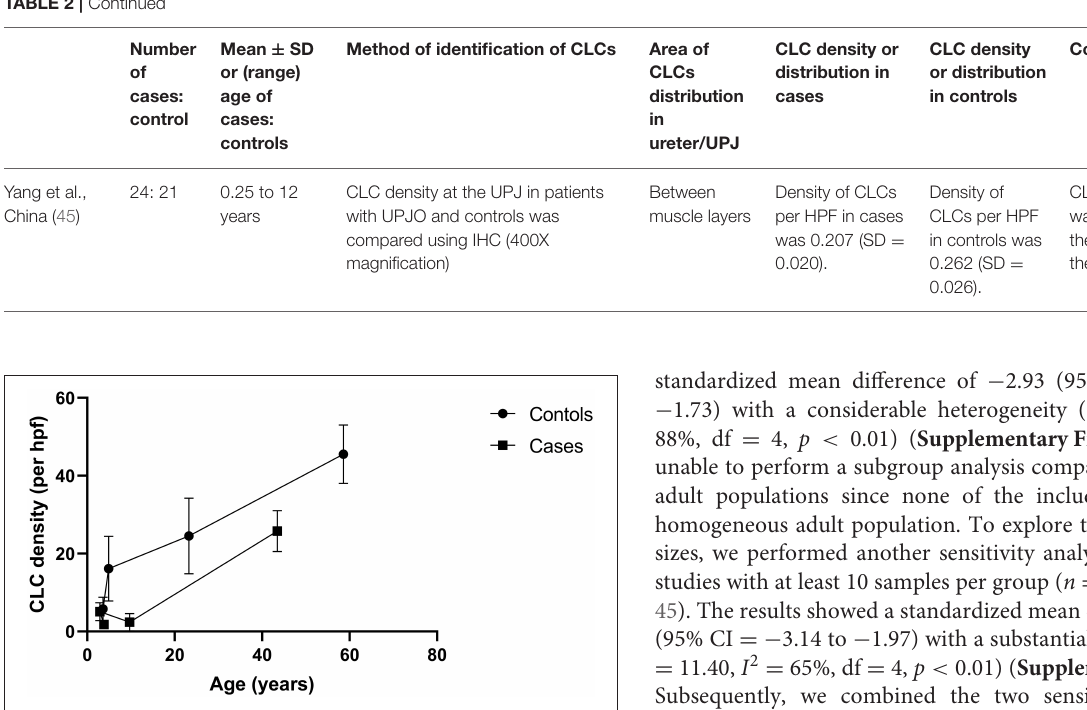
FIGURE 2 | A line diagram demonstrating the associations of density of Cajal like cells (CLCs) at the ureteropelvic junction and age. The diagram illustrates that the CLC density increases with age in both healthy and those affected with ureteropelvic junction obstruction. Data from four studies were used to create the chart ( 31, 32, 36,